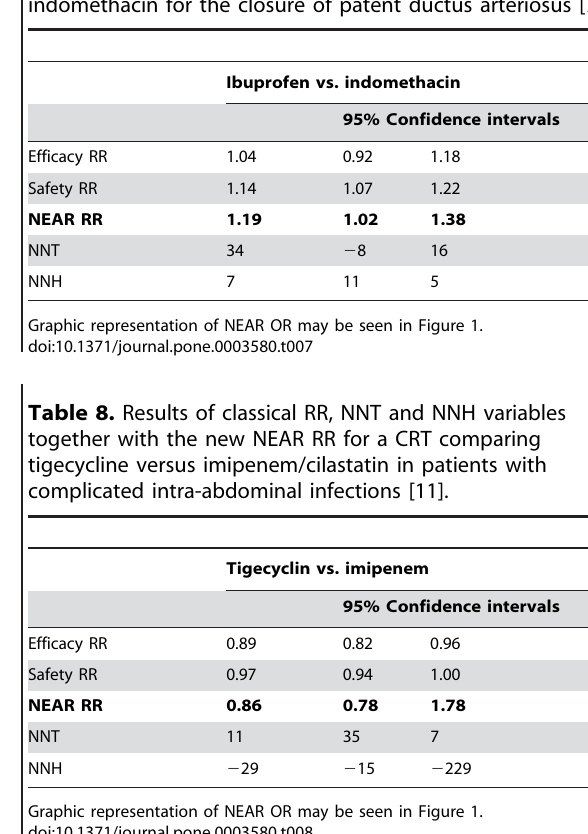
Graphic representation of NEAR OR may be seen in Figure 1. doi:10.1371/journal.pone.0003580.t008 Table 9. Results of classical RR, NNT and NNH variables together with the new NEAR RR for two CRT comparing. warfarin vs. aspirin for preventing thromboembolic events in patients suffering atrial fibrillation [12] and more intensive vs. less intensive statin therapy in cardiovascular diseases [13].